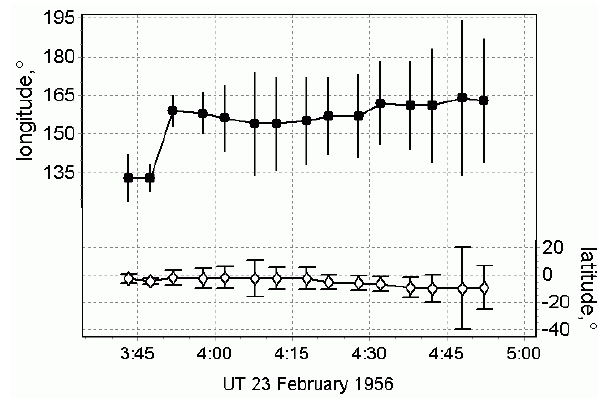
Figure 14 Fig. 14. Behavior of the anisotropy contribution A part and coeffi- cient n a , characterizing a width of angular distribution of the solar CR anisotropic flux.